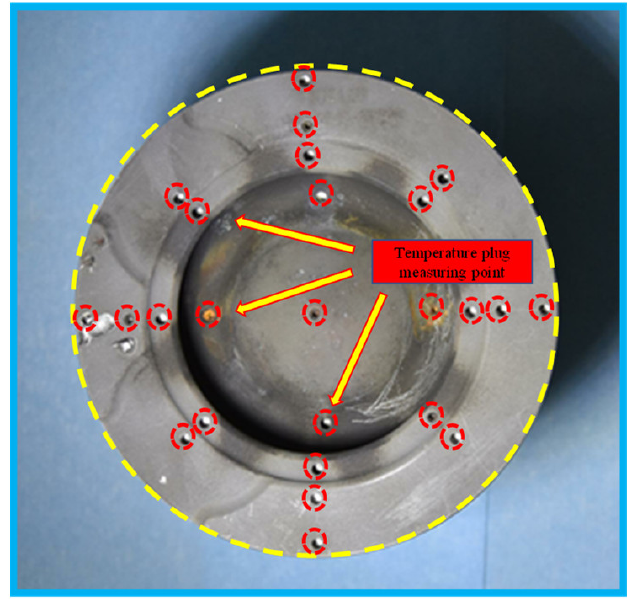
Figure 5. The experimented piston.